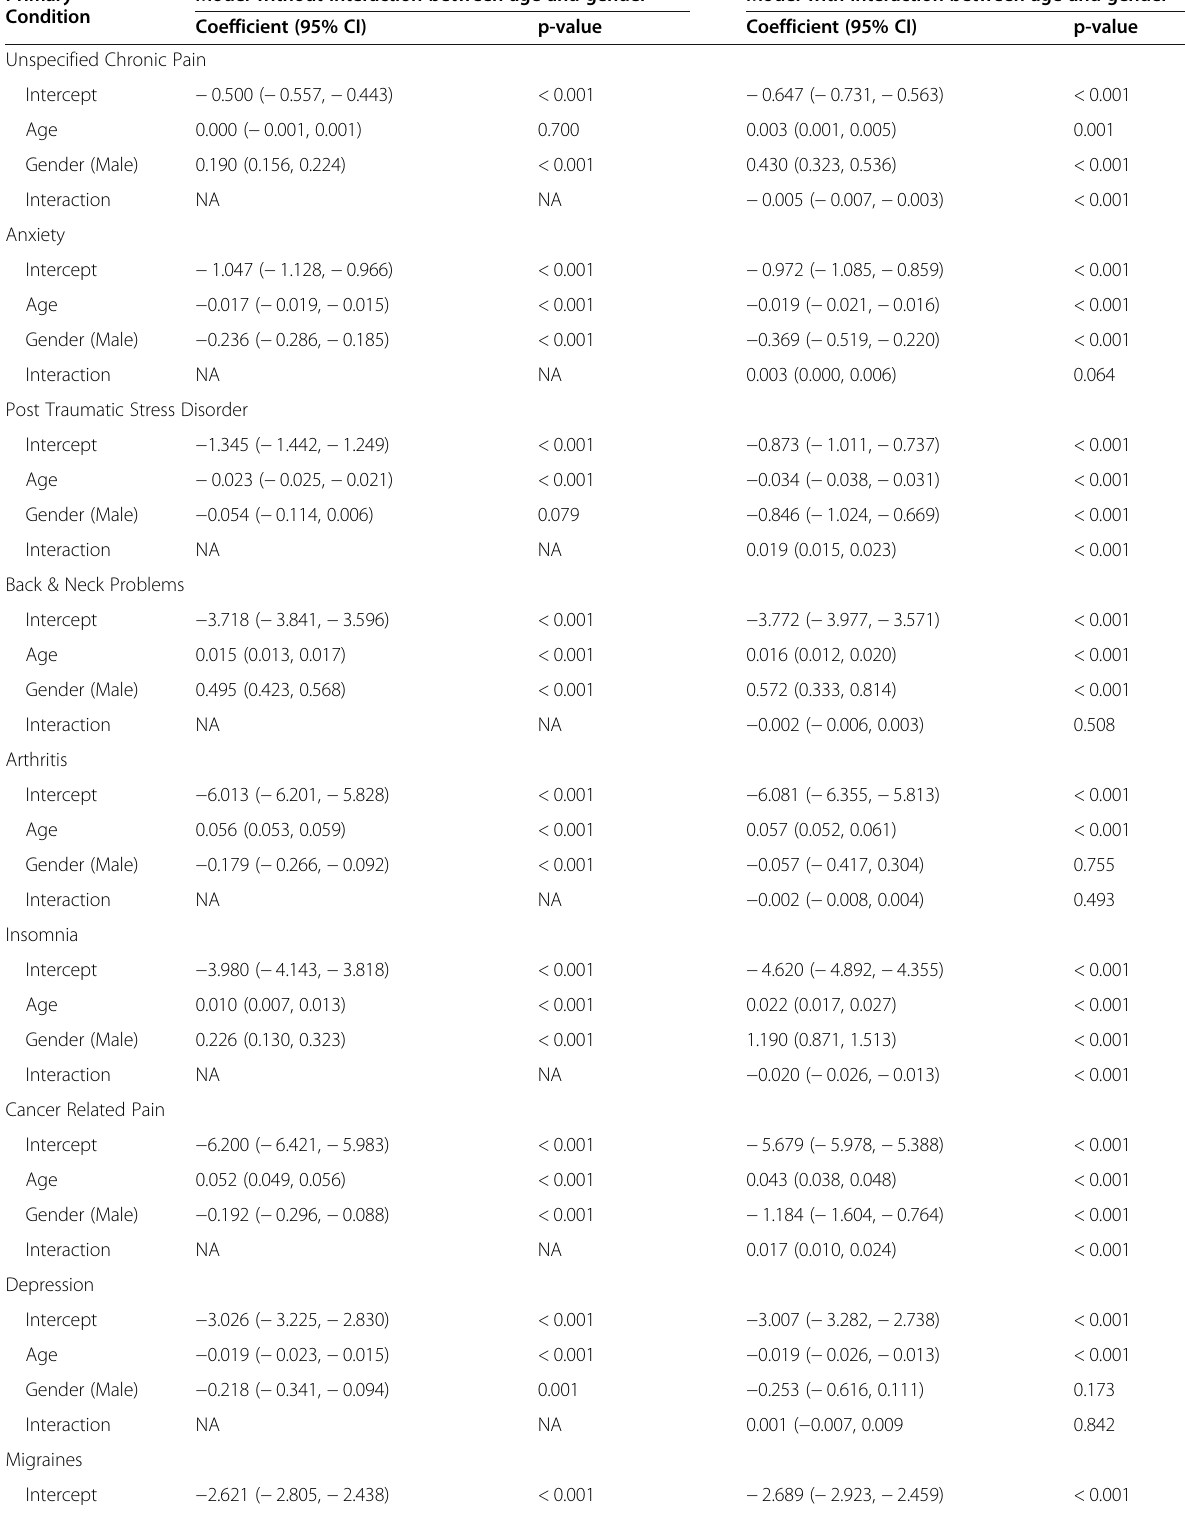
Table 6 Multivariate analysis results of differences in primary condition reported by 56,860 patients seeking medical cannabis certification by gender and age, with and without